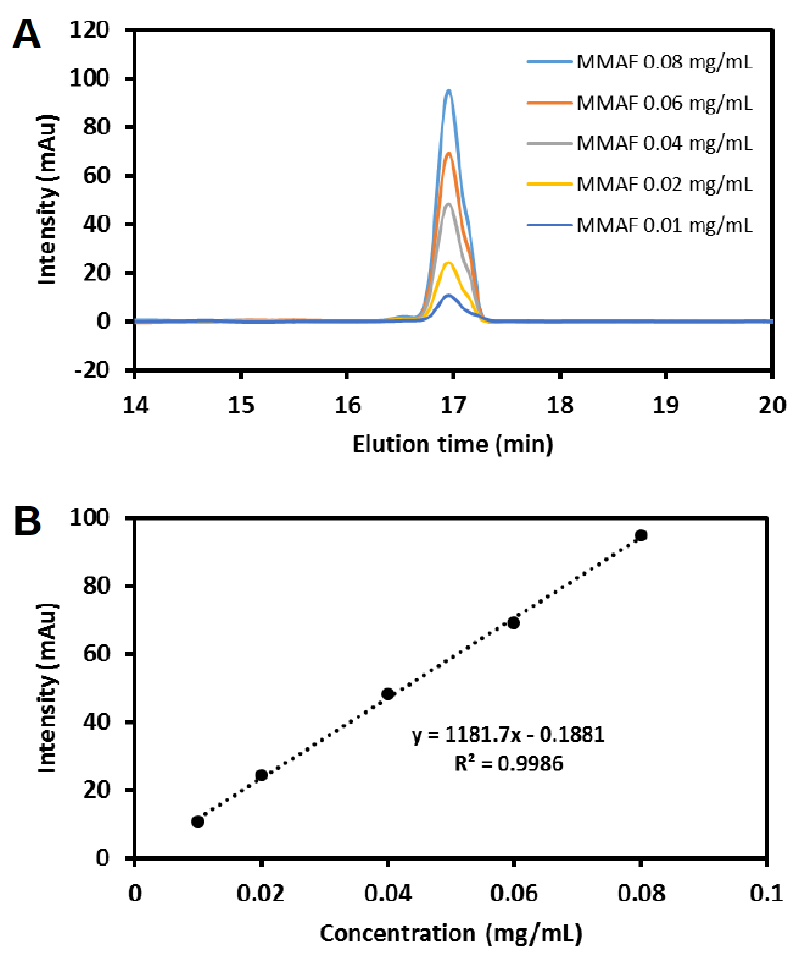
Figure 3. Quantification of MMAF using HPLC. ( A ) Concentration-dependent HPLC spectrum. ( B ) Standard curve of MMAF.